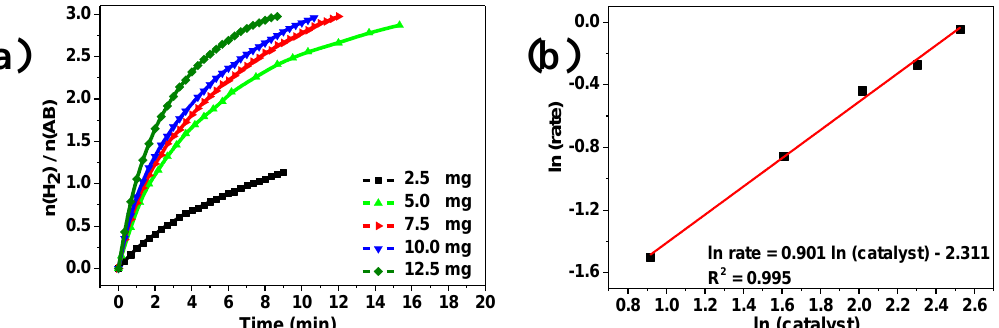
Figure 8. ( a ) n (H 2 ) / n (AB) vs. reaction time at di ff erent Cu 0.4 Co 0.6 MoO 4 / g-C 3 N 4 dosages; ( b ) the